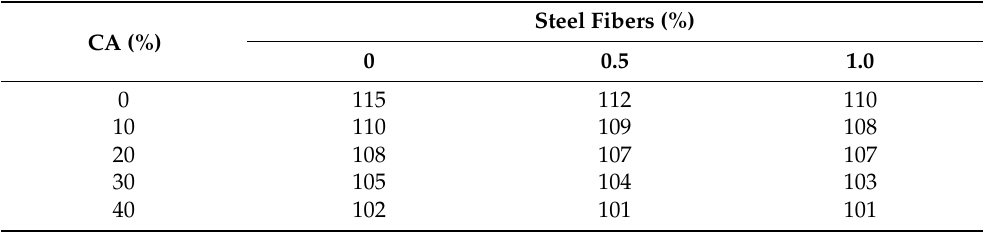
Table 6. Flow of mixtures (in mm) incorporating coal ash and steel fibers. CA